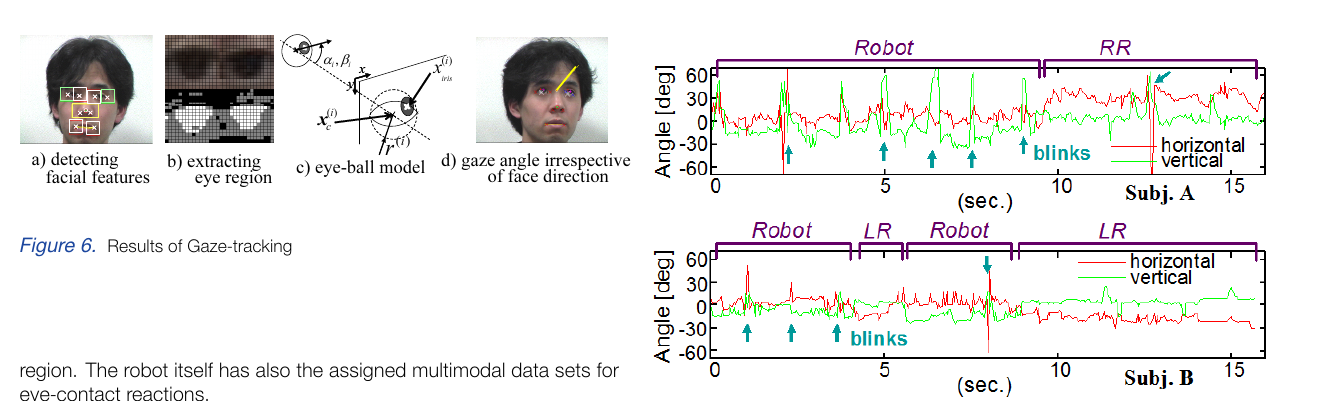
Figure 7. Examples of Estimated Gaze Angles